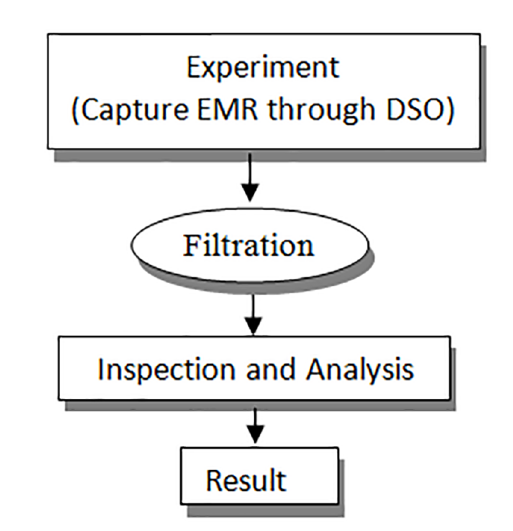
Figure 1. Flowchart of Experimental Design.